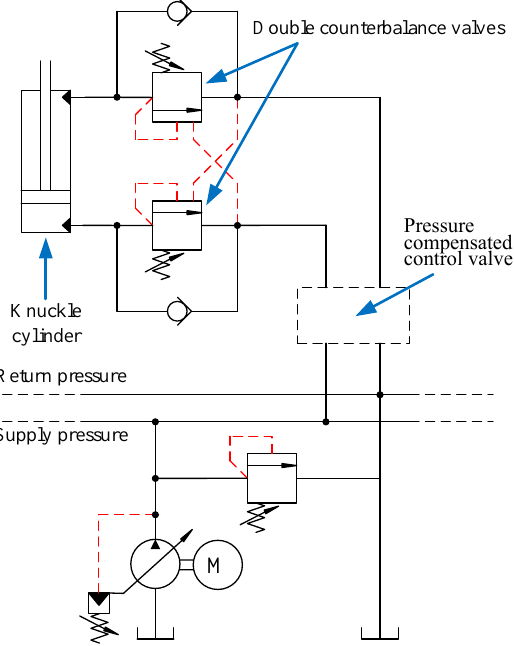
Figure 4. Hydraulic circuit for the knuckle